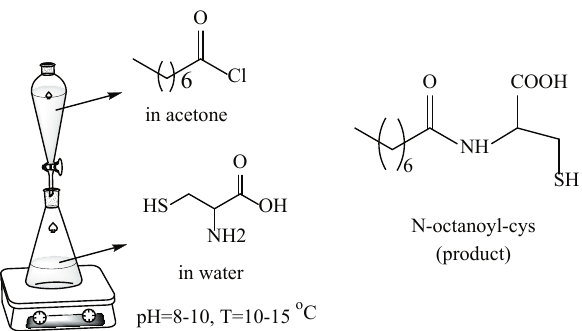
Figure 2. Schematic for the synthesis of octanoyl-cysteine sur- factant from octanoyl chloride, in acetone, and L-cysteine in water.